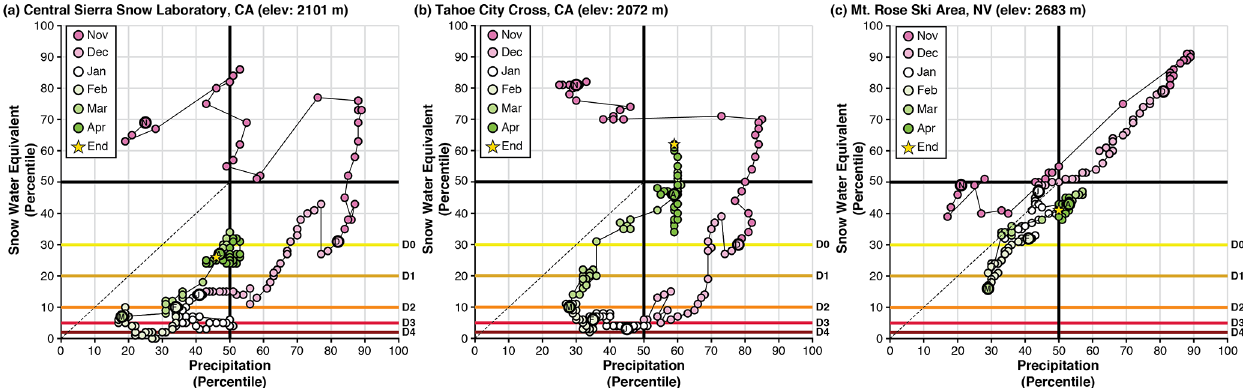
Figure 3. An elevation-longitudinal examination of snow drought conditions during water year (WY) 2018 in the northern Sierra Nevada of California and Nevada. Stations are ordered from west to east: (a) CSS Lab, (b) Tahoe City Cross, and (c) Mount Rose Ski